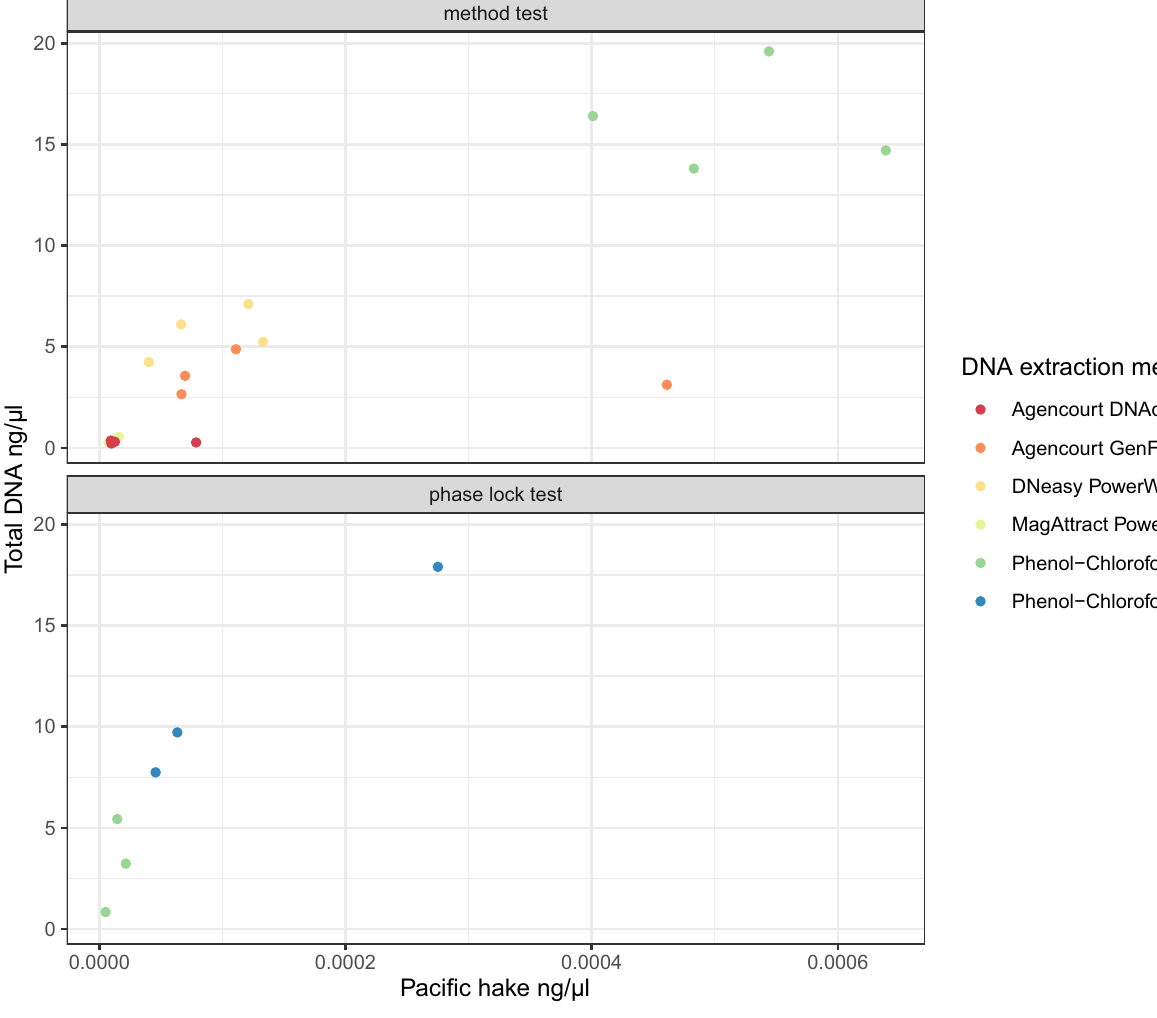
Fig 2. Comparison of total and target DNA quantification for five different DNA extraction methods (n = 20) and for the phenol-chloroform method with and without the phase lock with a different set of samples (n = 6, three filters split in halves). [Total DNA] was measured on the Qubit; [Merluccius productus] was measured by